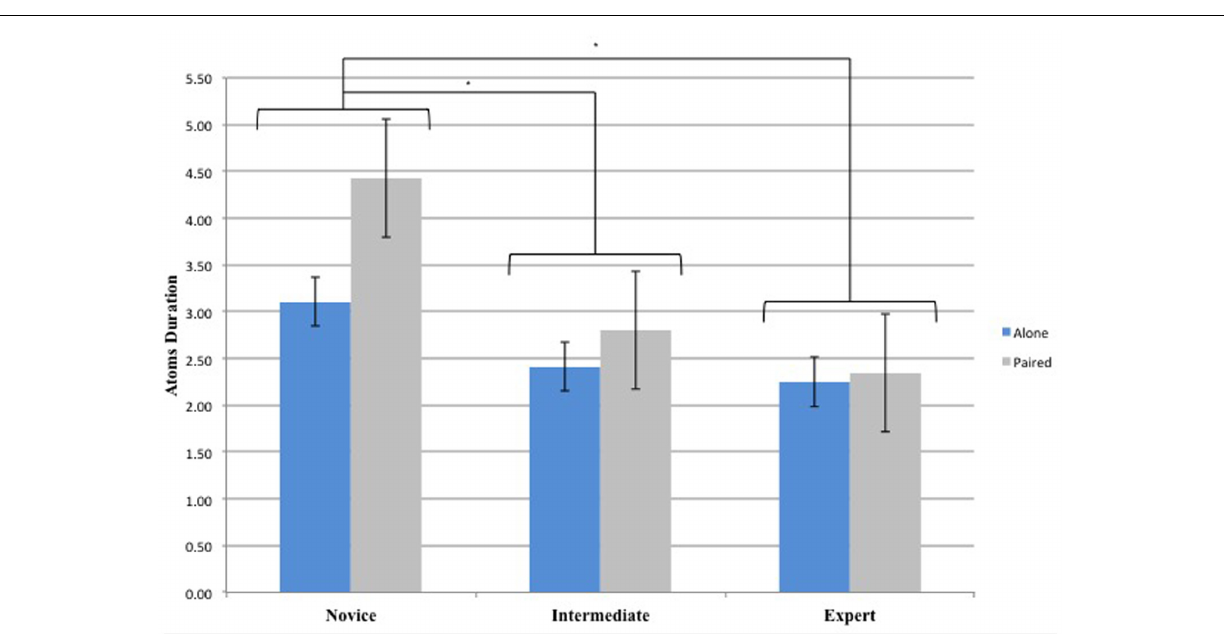
FIGURE 5 | Duration of the Atoms for the 3 Groups (Novice, Intermediate, and Expert) and the 2 Conditions (Alone and Paired). ∗ Asterisks indicate significant differences P <